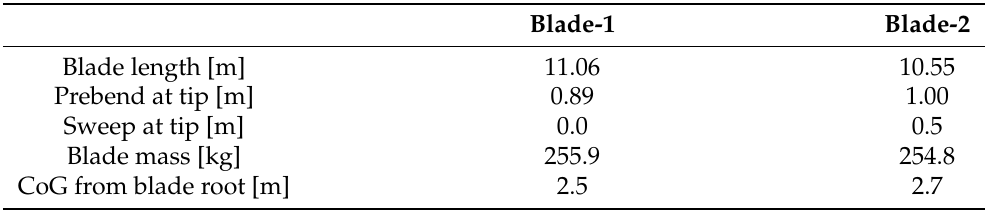
Table 2. Blade dimensions and mass properties for both